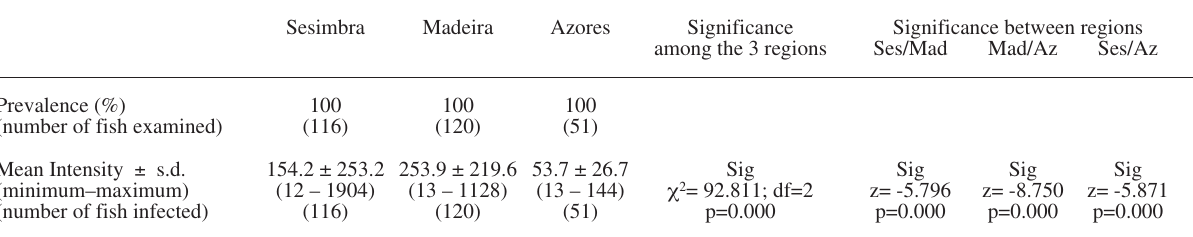
Table 2. – Prevalence and mean intensity of Anisakis larva infection in Aphanopus carbo from the studied regions: significance of intensity differences among regions estimated by the kruskal-Wallis ( c 2 ; df; p) or Mann-Whitney (z; p) test (sig, significantly